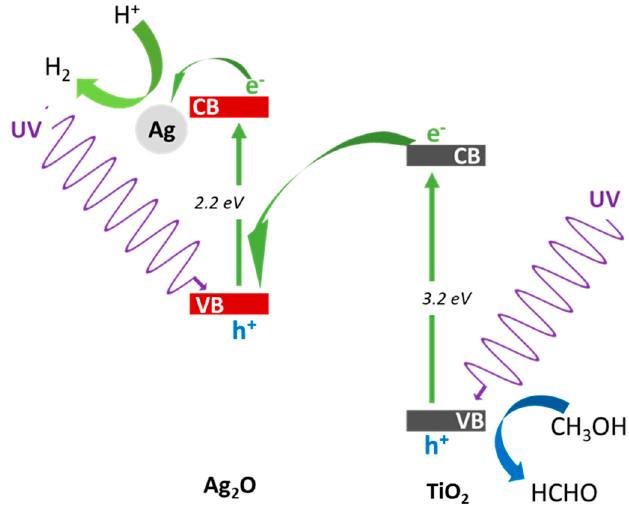
Figure 6. The schematic mechanism of Z-scheme for UV/vis-induced methanol dehydrogenation with Ag(0)/Ag 2 O/TiO 2 photocatalysts.